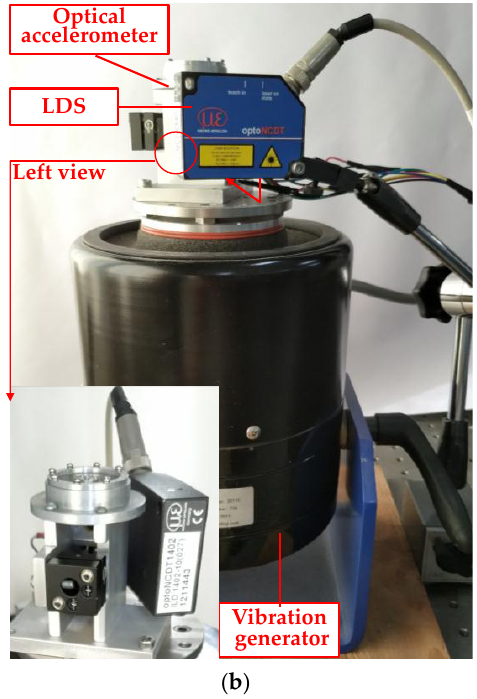
Figure 6. Experimental setup for the designed optical accelerometer calibration. ( a ) Diagram, ( b ) photo. LDS: laser displacement sensor.